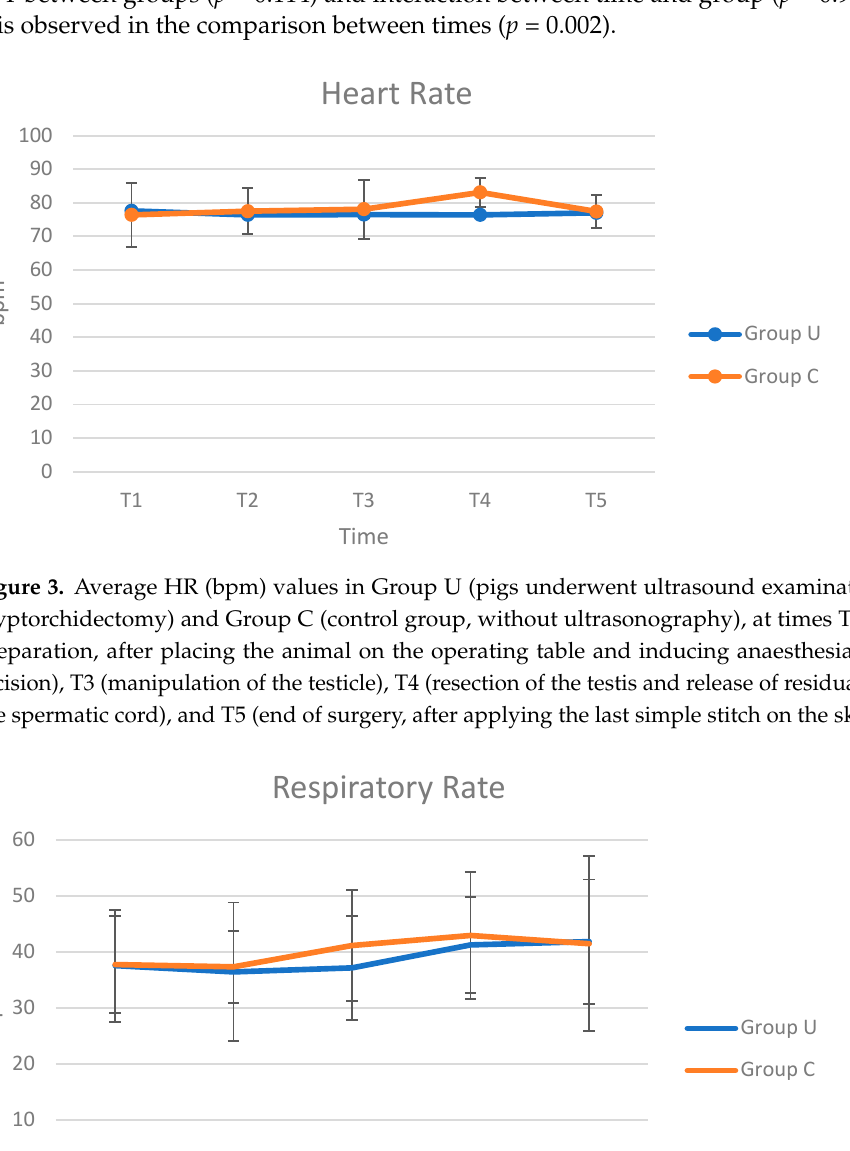
( p = 0.540), and between times ( p = 0.737). As RR, in both groups, the values increased at T4 and T5. From the analysis of ANOVA for repeated measures, no statistically significant differences were observed in the comparison of RR between groups ( p = 0.485), interaction between time and group ( p = 0.971), and between times ( p = 0.427). The T values decreased from T1 to T3, followed by an increase until at T5. From the analysis of ANOVA for repeated measures, no statistically significant differences were observed in the comparison of T between groups ( p = 0.114) and interaction between time and group ( p = 0.937), while it is observed in the comparison between times ( p = 0.002).